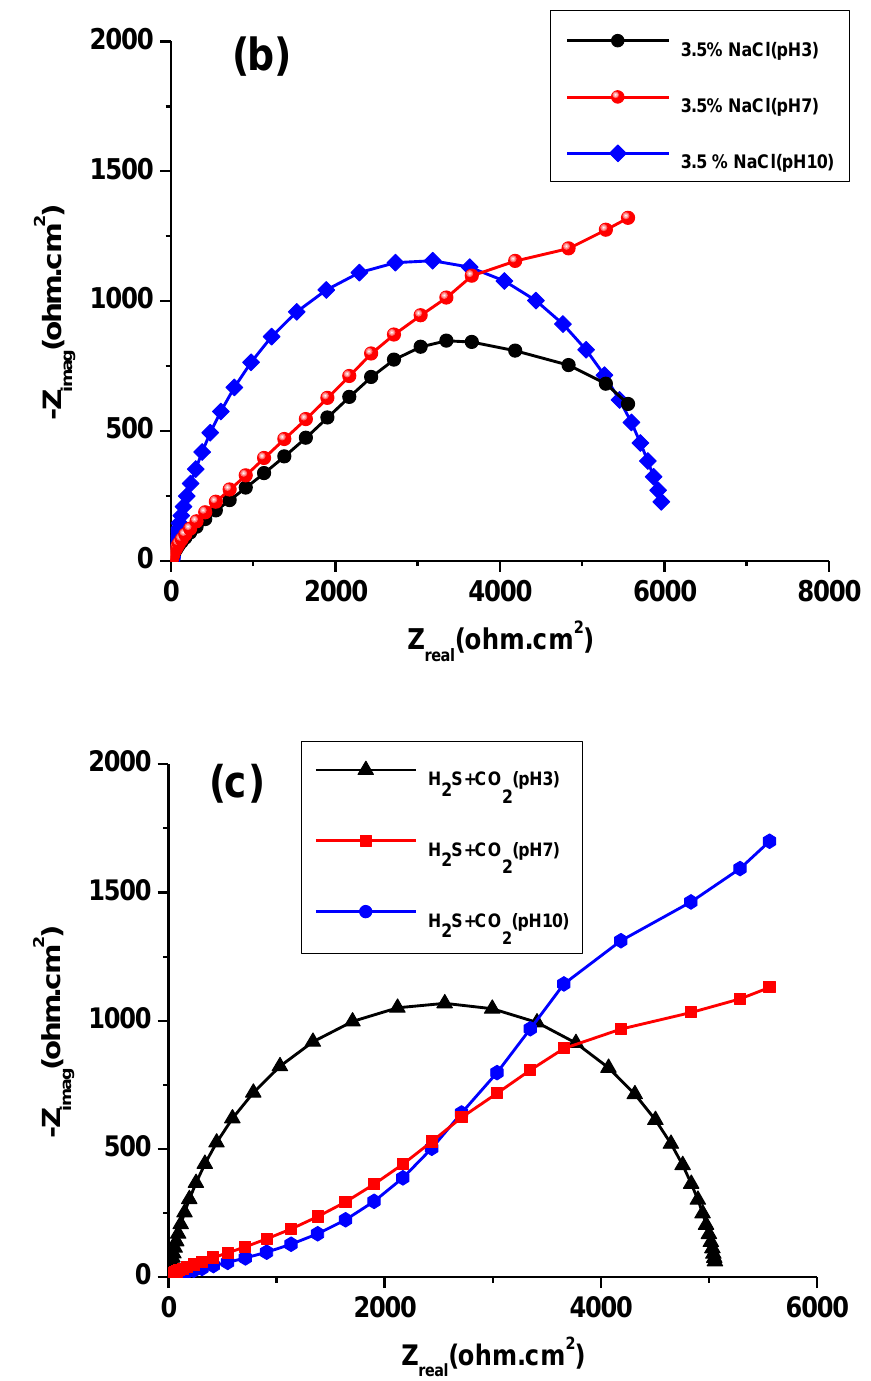
Figure 4. Nyquist plots in different solutions with different pH levels: ( a ) 3.5% NaCl + CO 2 , ( b ) 3.5% NaCl, and ( c ) CO 2 + H 2 S solution.